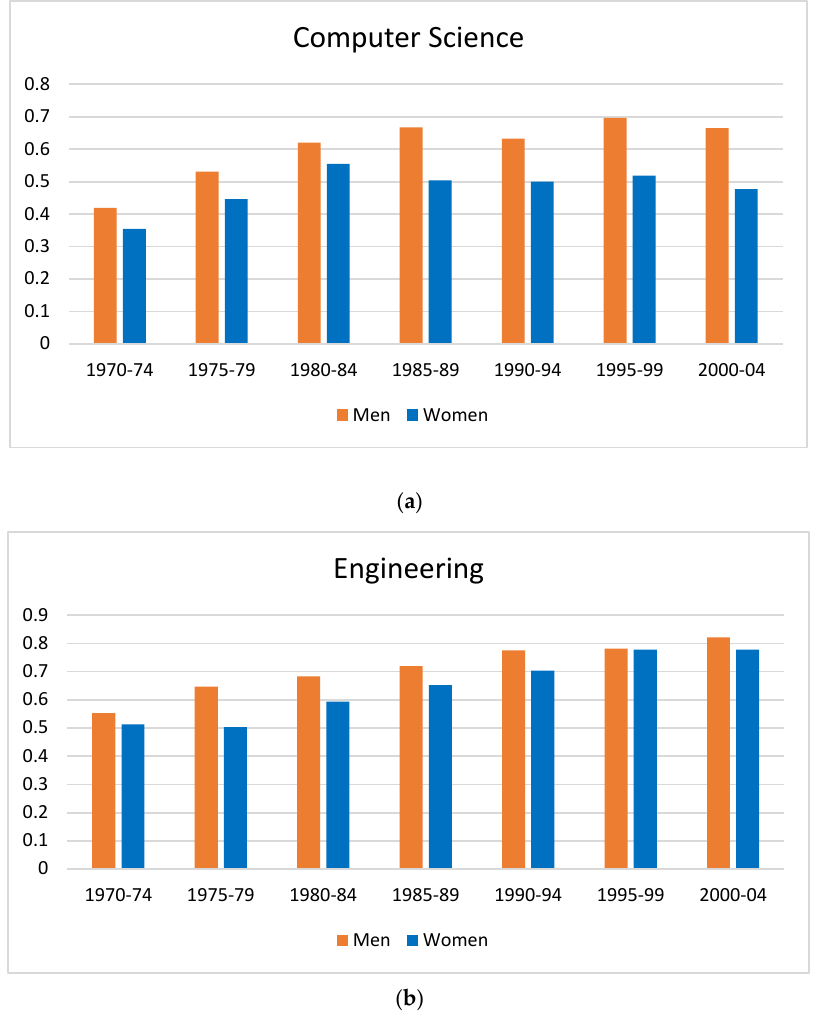
Figure 4. Predicted Probabilities of Working in STEM by College Cohort for Women and Men. (a)